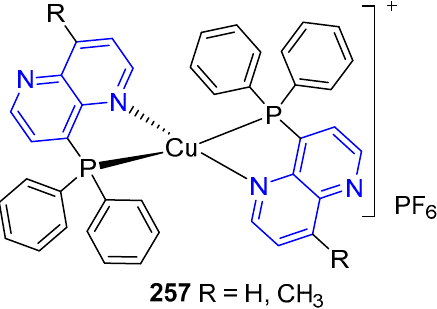
Figure 35. Fluorescent copper complexes.